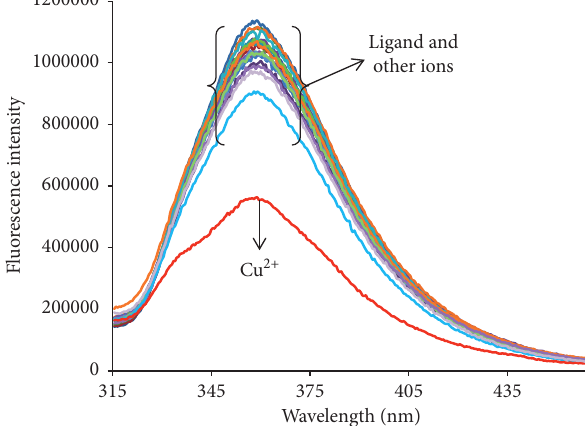
Figure 3: The effect of metal ions on fluorescence spectra of L in acetonitrile-water (1:1). L : 2.0 × 10 − 7 M; metal ion: 2.0 × 10 − 6 M.